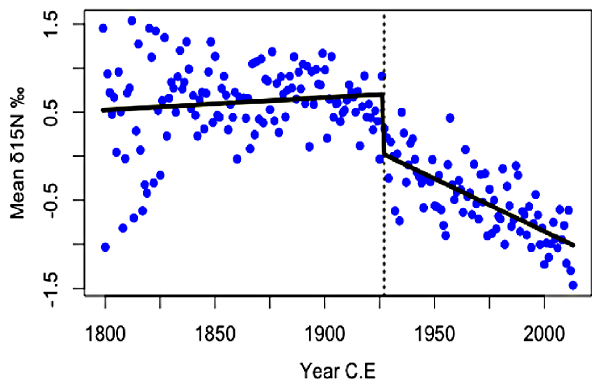
Figure 3. Piecewise regression line fit to the standardized δ 15 N for the entire study site. For purposes of larger sample size, data for the period 1800–2013 were selected. The dashed line repre- sents the significant change point of 1927 determined by change- point tests. Sen’s slope prior to the determined 1927 breakpoint based on Mann–Kendall trend test is slightly positive albeit not significant ( p = 0.972). The period of 1927–2013 has a significant ( p <0.00001) Sen’s slope of −